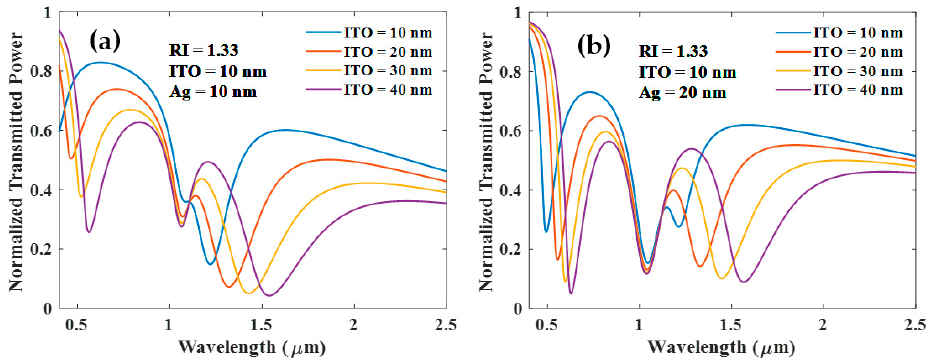
Figure 8. Normalized transmission spectra of sensing probe with ( a ) ITO (10 nm) + Ag (10 nm) + ITO (X nm)